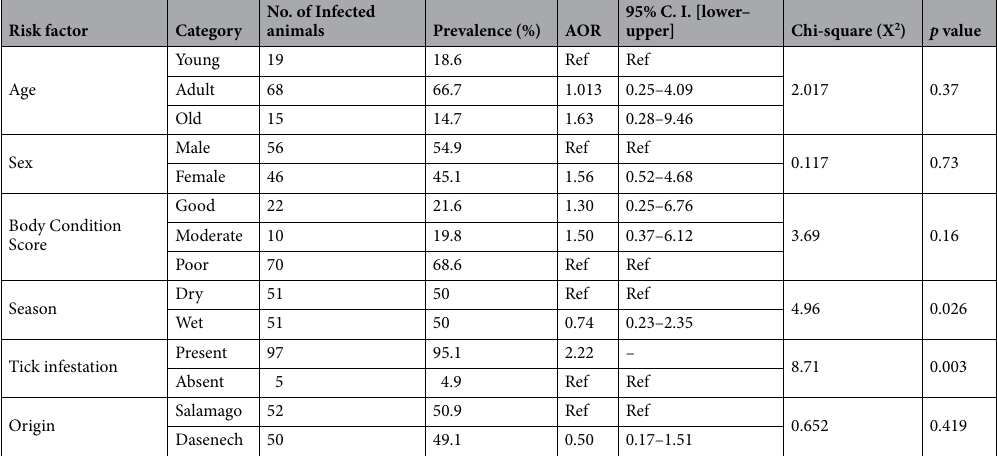
No. of Infected animals Prevalence (%) AOR